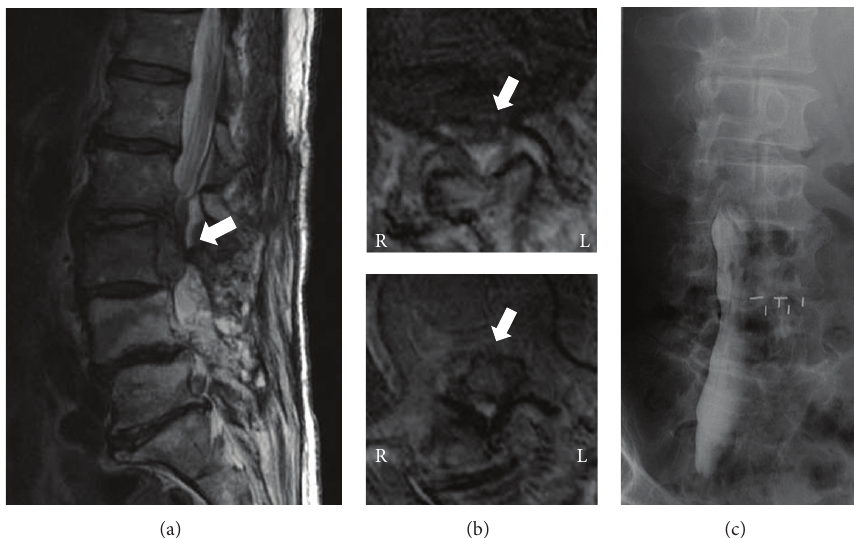
Figure 1: (a) Sagittal T2-weighted magnetic resonance image at the time of admission demonstrating a large descending disc hernia from the L2/3 to L3 levels. (b) Axial T2-weighted image of the L2/3 level (upper) and L3 vertebra level (lower) showing a hernia (arrow) compressing the spinal cord posterolaterally. (c) Myelogram obtained in a head-lowering prone position showing obstruction at the L3 vertebra level.